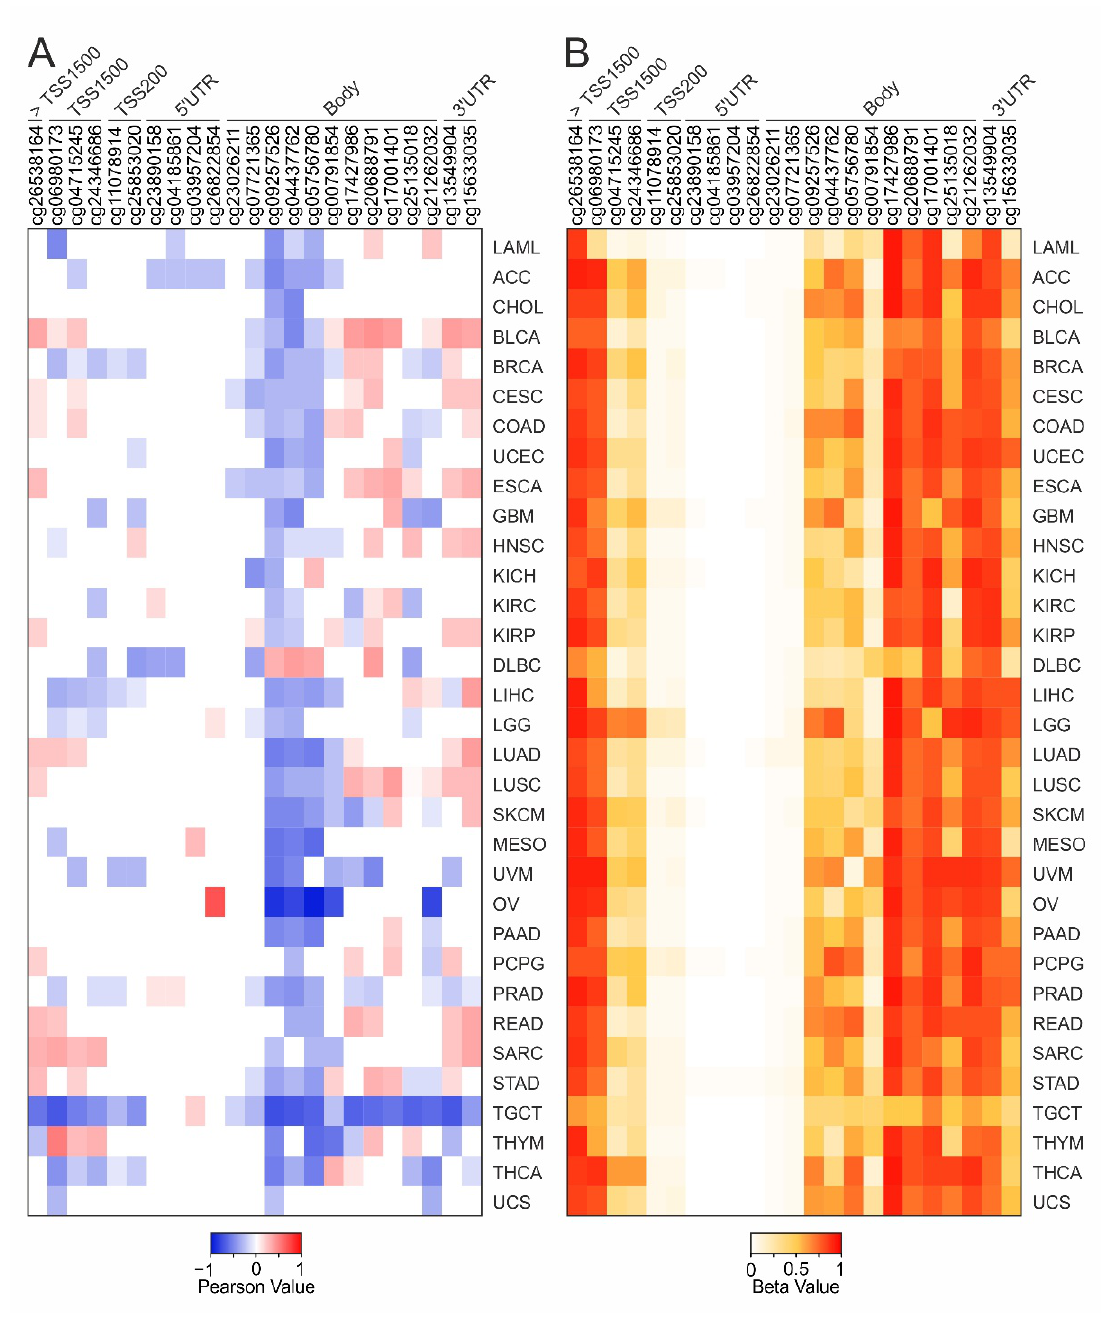
Figure 3. Correlation analysis between IL6R expression and DNA methylation for each tumor type. ( A ) The heatmap shows the significant ( p ≤ 0.05) Pearson’s correlation coefficients ≤ − 0.3 (blue) or ≥ 0.3 (red). ( B ) DNA methylation levels of IL6R CG probesets for each tumor type. The heatmap cell represents the mean values of methylation levels for each CG probeset.